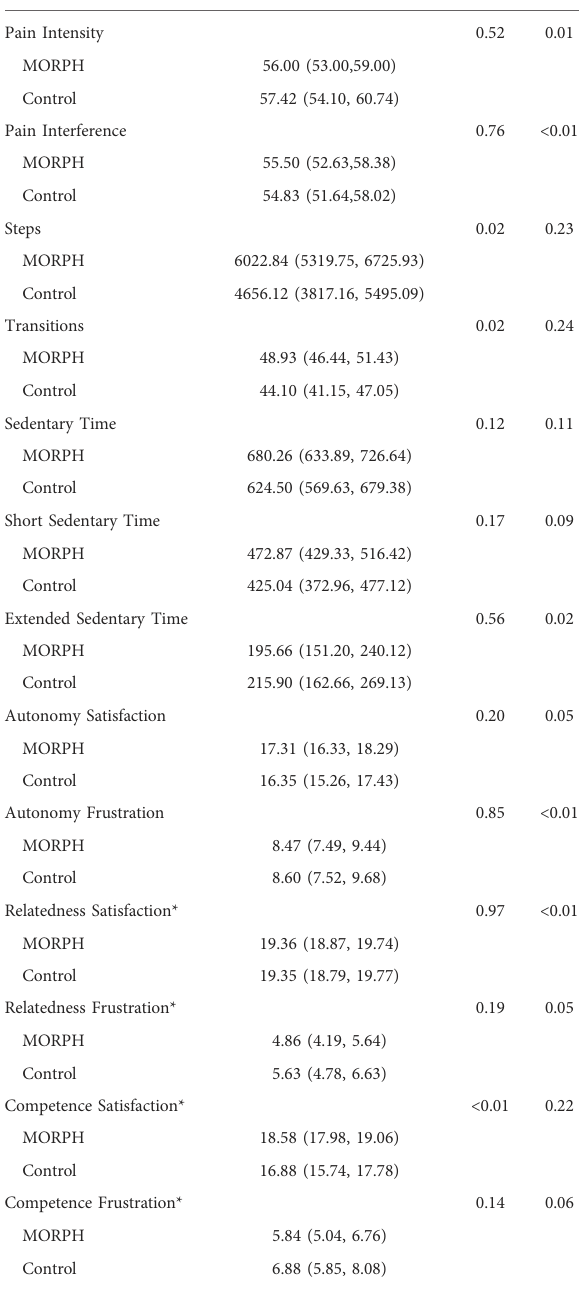
TABLE 4 Baseline-adjusted scores at week 12; p values and effect sizes were obtained from ANCOVA models. *Transformation applied due to heterogeneous variances or non-Normal residuals. Back-transformed data presented here. Short sedentary time captures average daily minutes sedentary bouts of less than 60 min, and extended sedentary time captures average daily minutes in abouts of at least 60